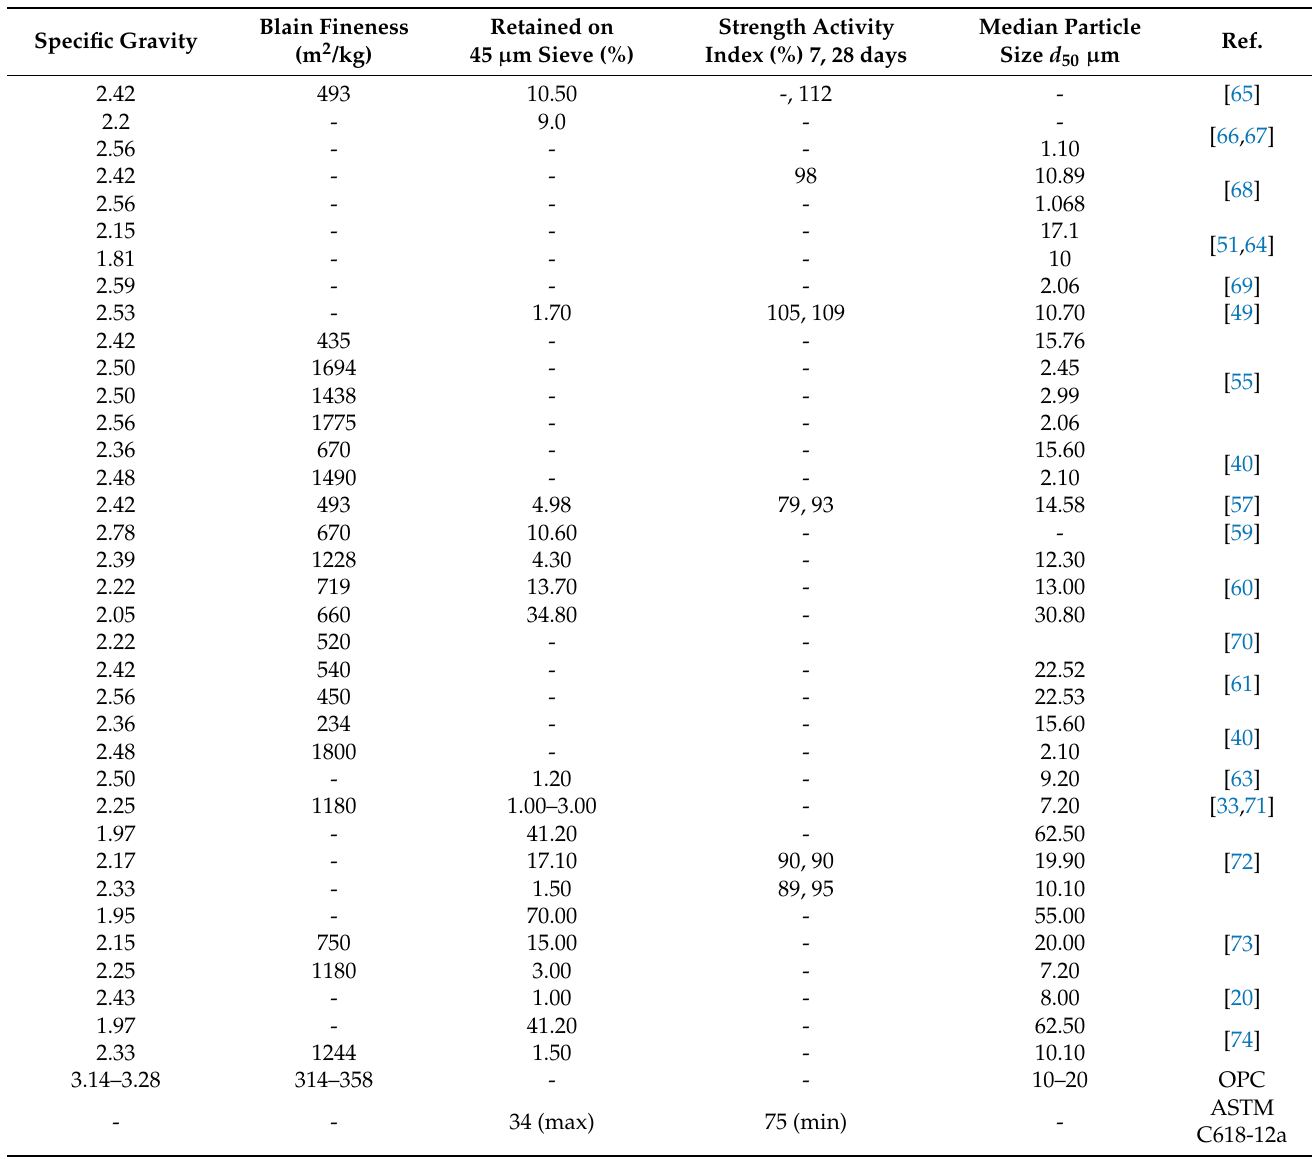
Table 3. Physical properties